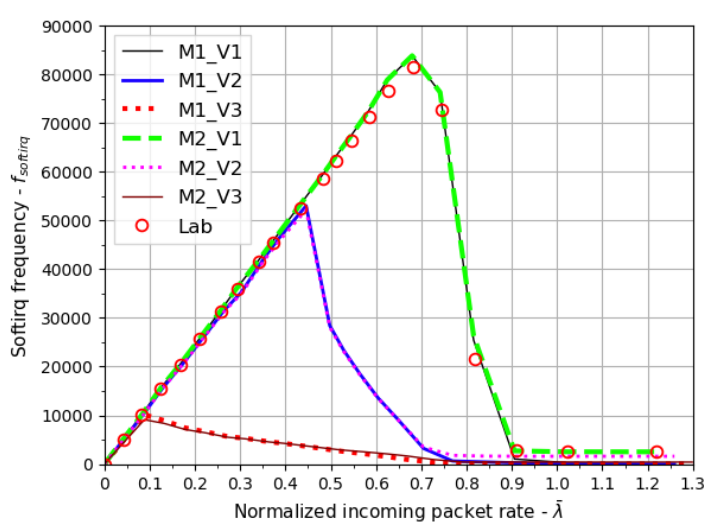
Figure 9. Results of softirq frequency for different scenarios (V1, V2, and V3).